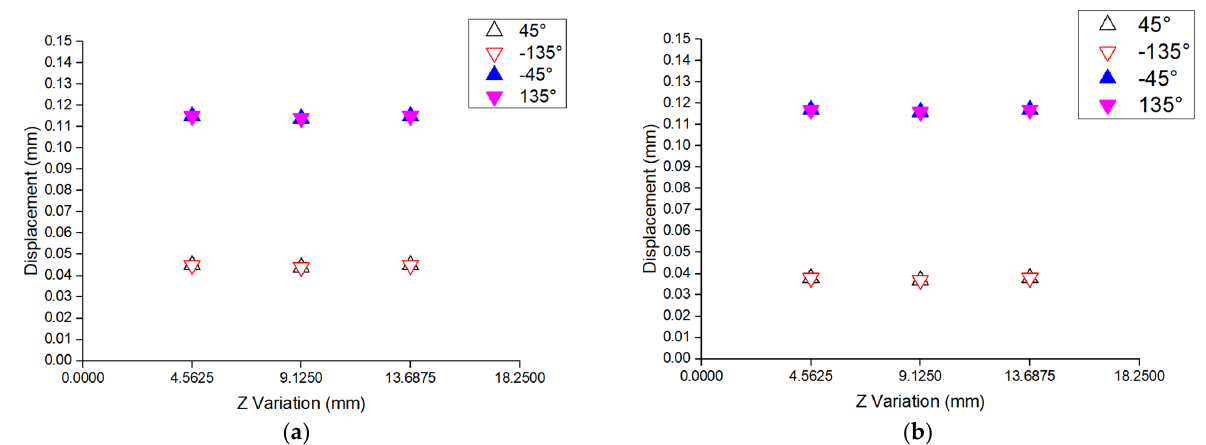
Figure 16. Maximum and minimum deformation in different height directions. ( a ) Results of or- thogonal symmetrical heat transfer; ( b ) Results of external orthogonal symmetrical and internal ax- ial symmetry heat transfer.